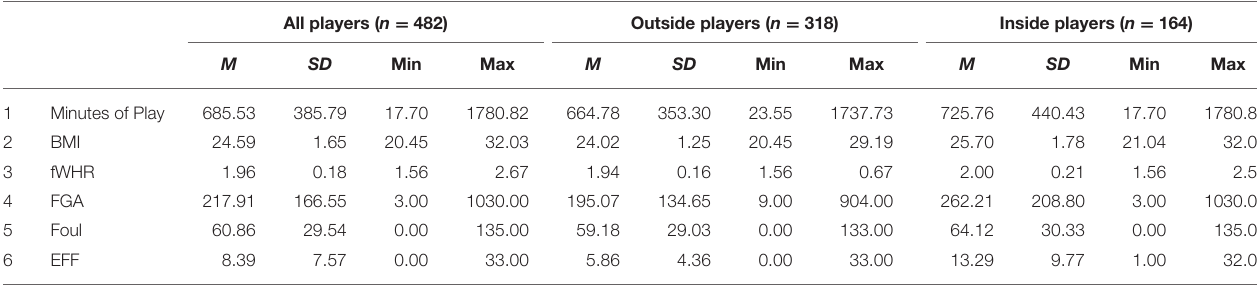
TABLE 1 | Descriptive